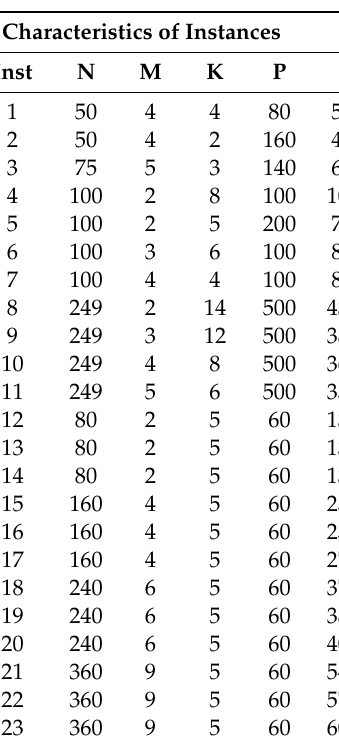
Table 1. The results on the benchmark instance.